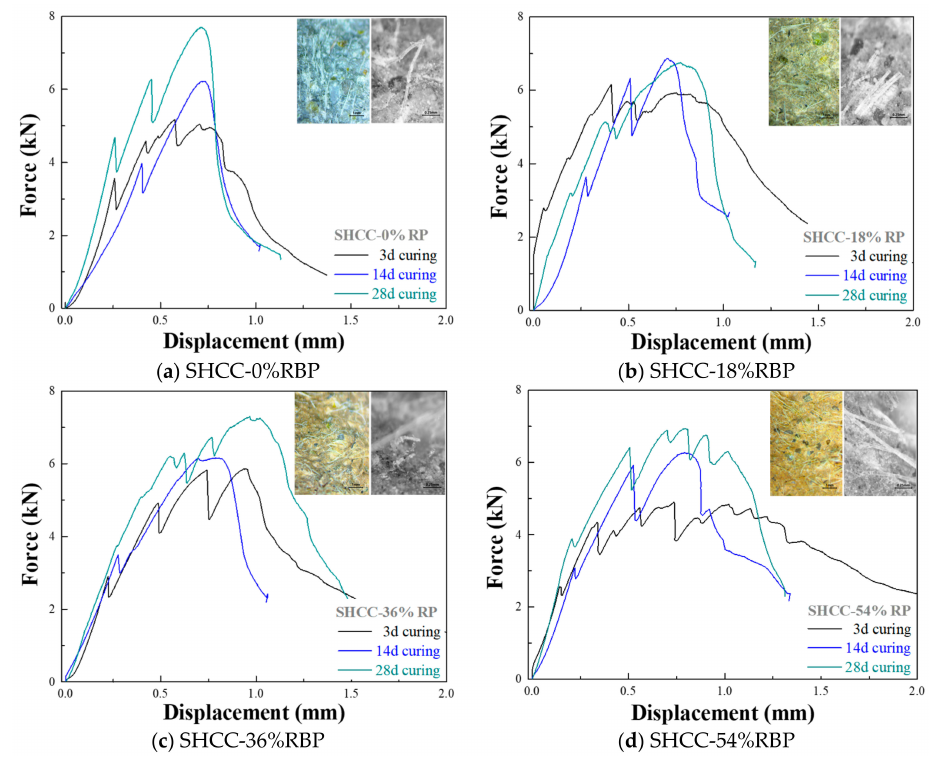
Figure 11. Force-displacement curves of SHCC containing RBP after various curing days. ( a ) SHCC-